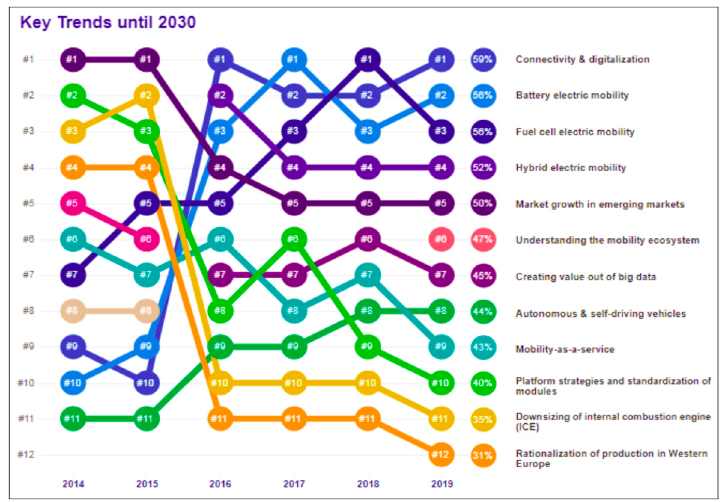
Figure 14. Automotive executive survey. Reproduced with permission from KPMG Netherlands, 2019.